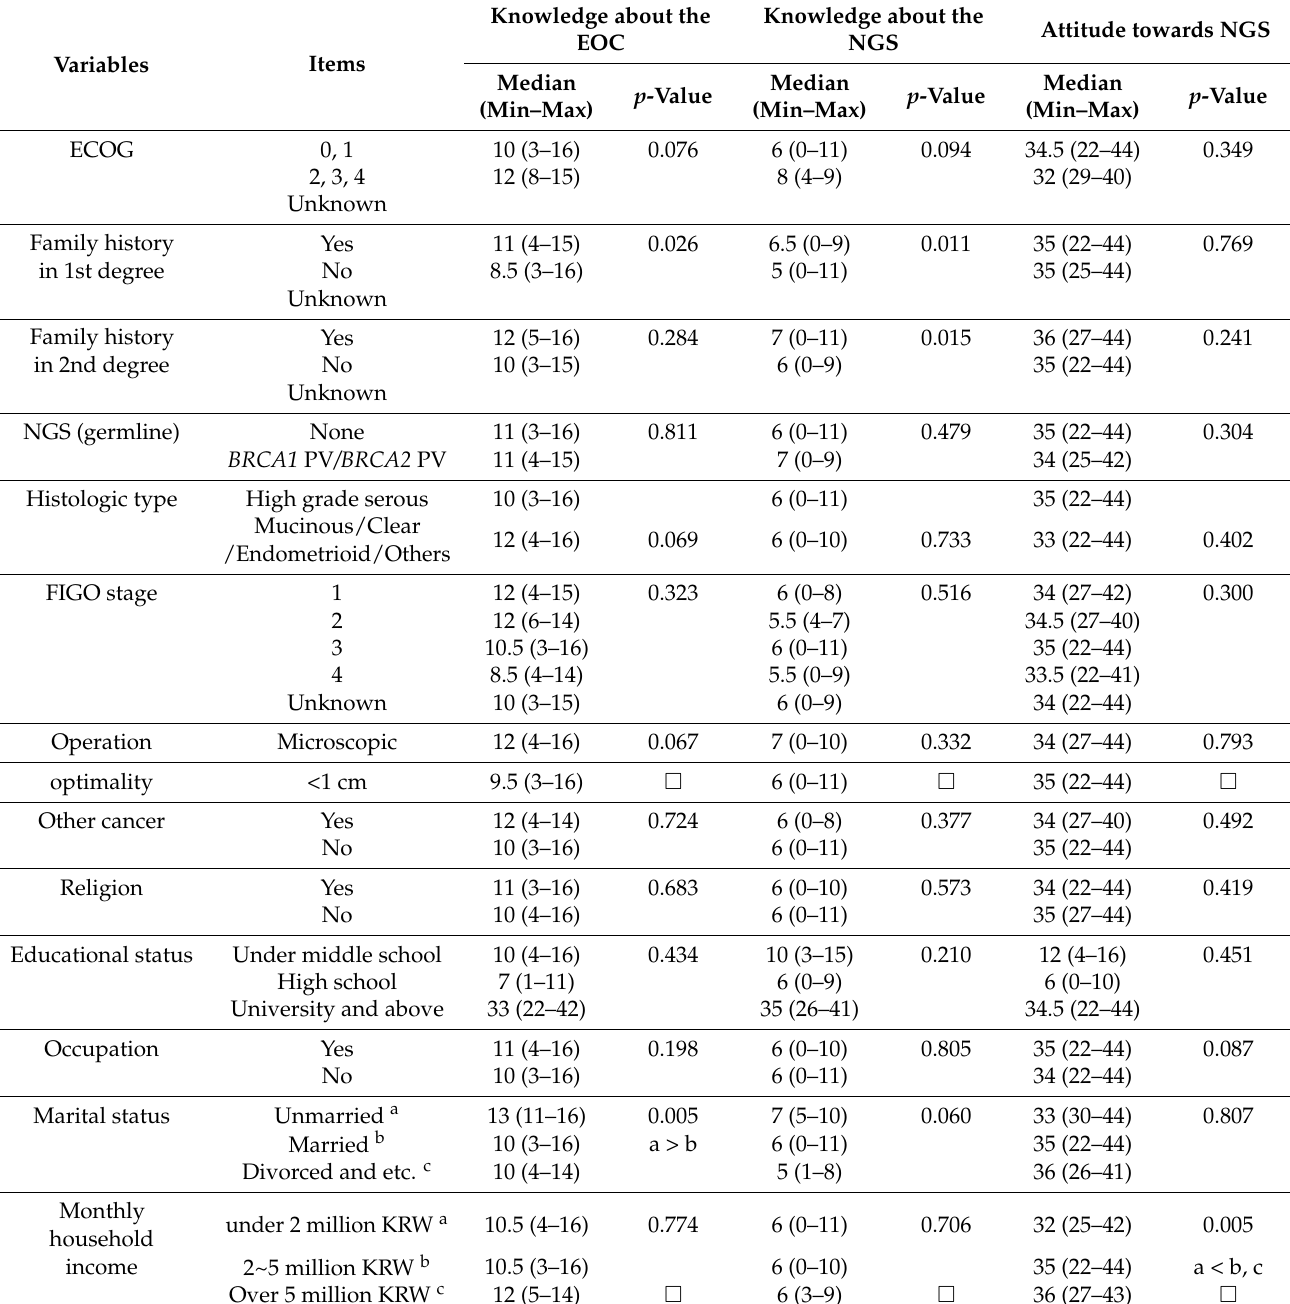
Table 4. The differences of knowledge about the ovarian cancer and NGS and attitude towards NGS by participants’